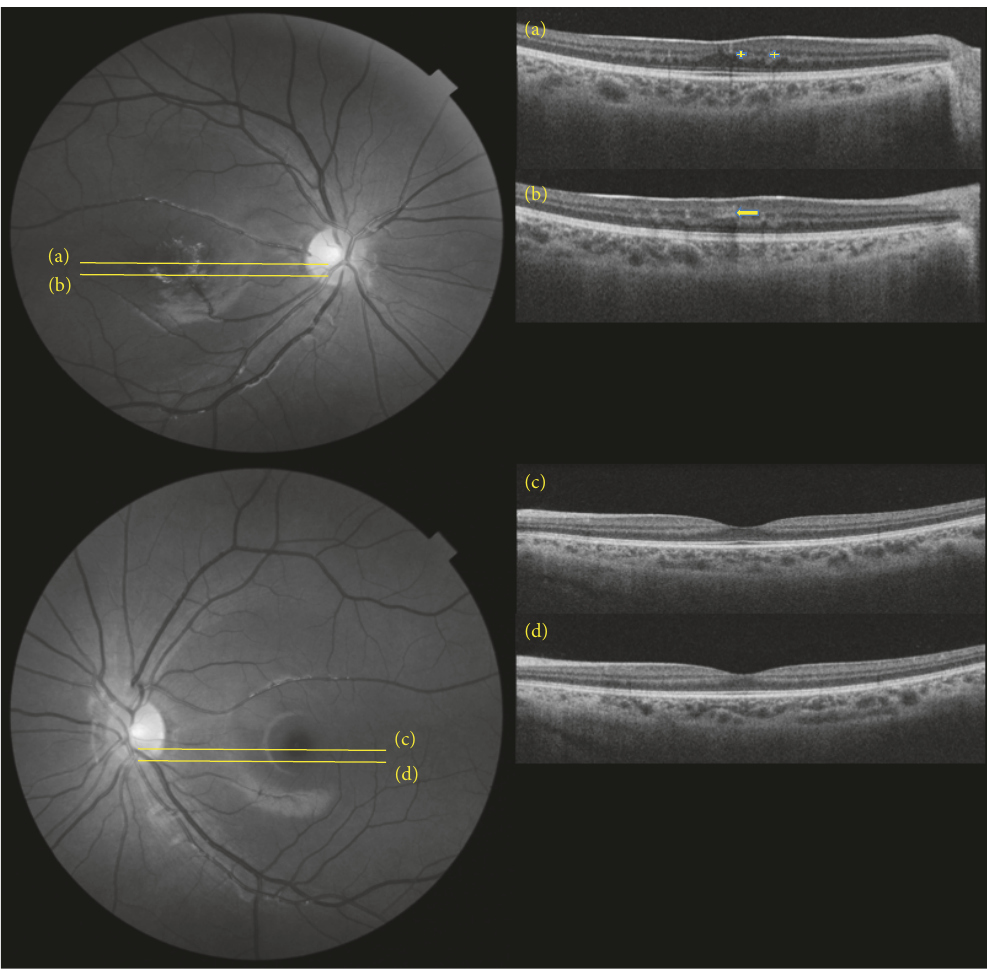
Figure 3: Swept-source OCT at the level of the right fovea (a) and inferior to the fovea (b) in a 12-year-old patient with congenital retinal macrovessels. The stem of the vessel is depicted at the level of the inner nuclear and plexiform layers (arrow) and its branches at the level of the outer nuclear layer (+). The foveal anatomy is largely preserved, though the foveal depression is reduced. There is no evidence of disturbance of the RPE-choriocapillaris complex also confirmed by OCT-A in the previous image. Corresponding swept-source OCT scans at the level of the left fovea (c) and inferior to the fovea (d) are included for